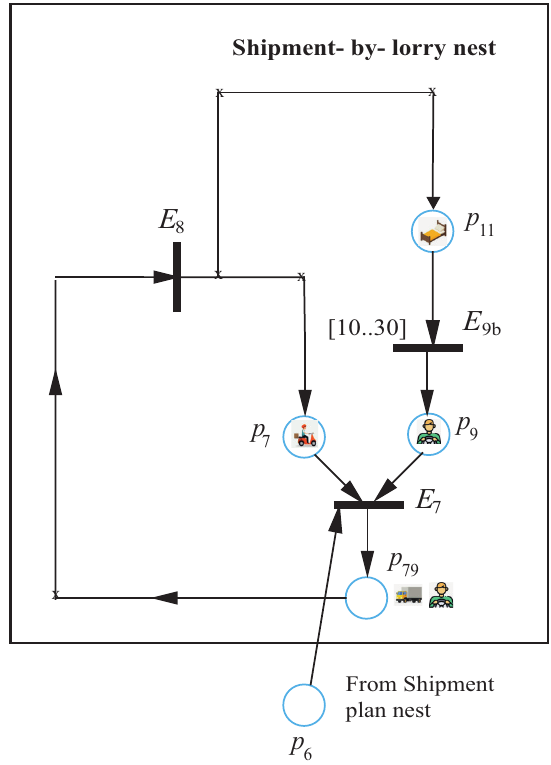
Figure 10. Hierarchical modeling of the courier example: shipment-by-motorbike. Table 5. Description of places for the courier company